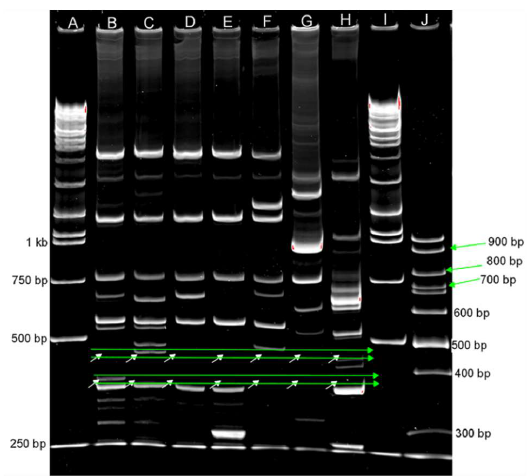
Figure 1. PCR products of C. rosea isolates using the AS15 and L21 primer combination resolved on